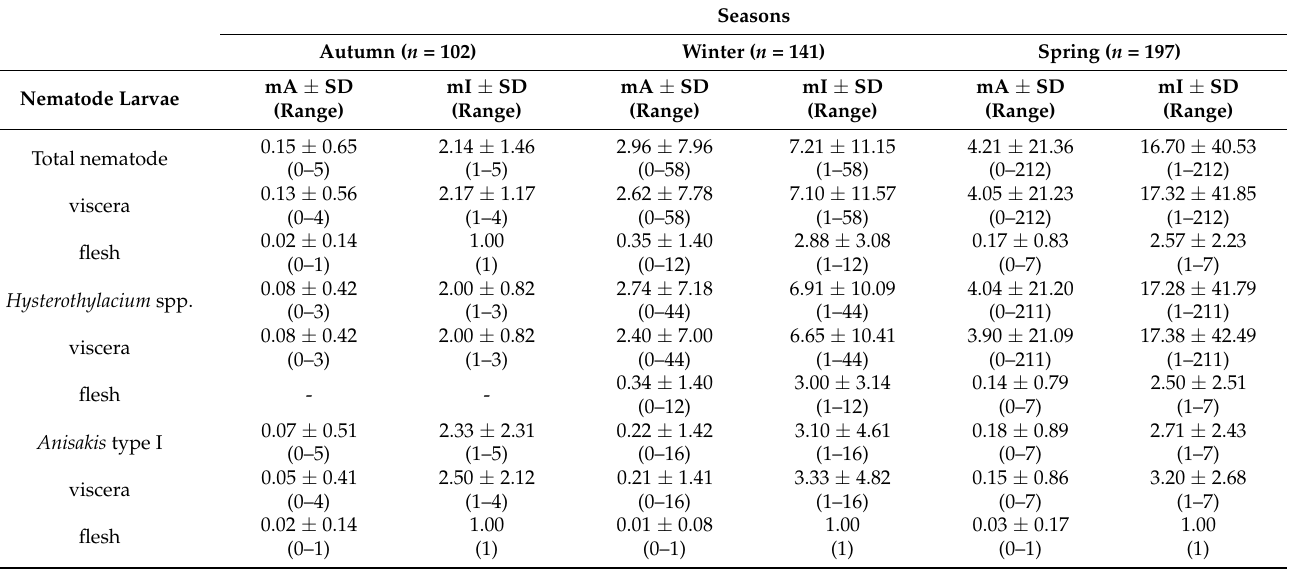
Table 5. Mean abundance (mA), mean intensity (mI), standard deviation (SD) and range of nematode larvae in sardines according to the season of